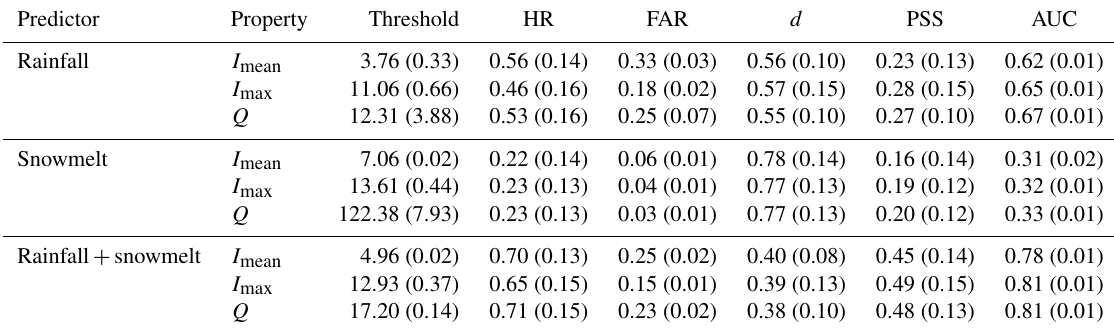
Table A2. K -fold validation results. Mean values and standard deviations (in parentheses) for thresholds of I mean (mmd − 1 ), I max (mmd − 1 ), and Q (mm) for entire events of rainfall, snowmelt, and the sum of rainfall and snowmelt (rainfall + snowmelt), as well as corresponding performance statistics.